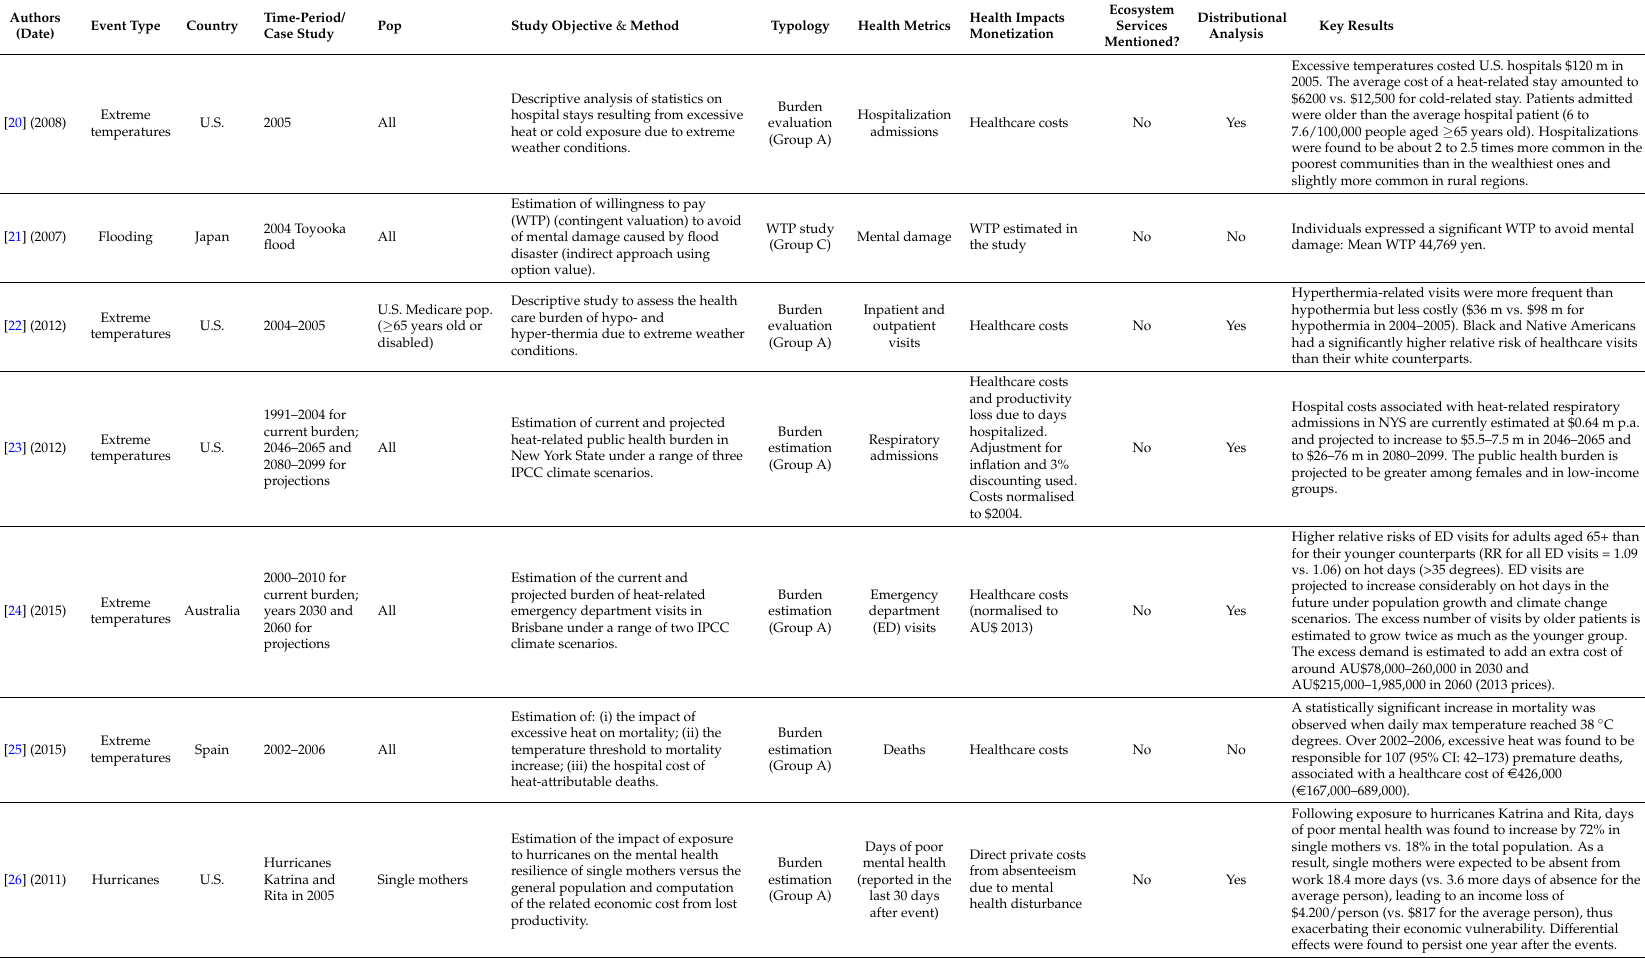
Table 1. Information extracted from the pool of relevant